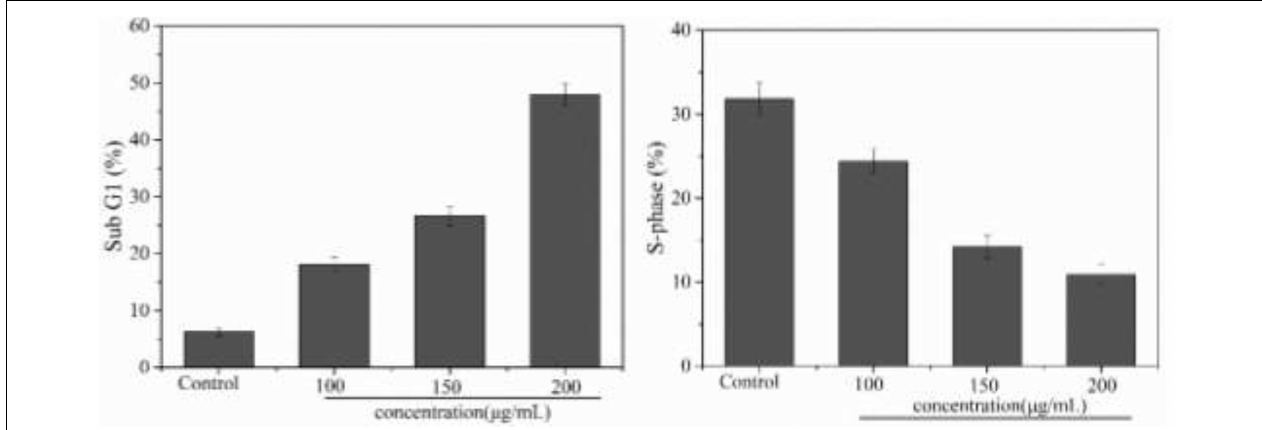
FIGURE 8 | Cell cycle effect of PNHE in MCF-7 cells stained with PI and analyzed by flow cytometry. Sub G1 peak and S-phase content were measured after treatment with different concentrations of PNHE for 24 h. All data are mean ± SD, n = 3.